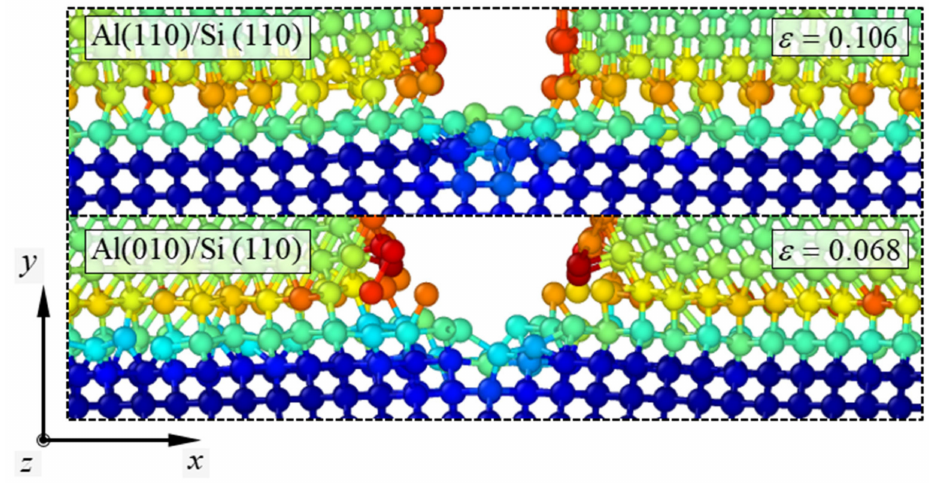
Figure 5. Atomic configurations of the interfaces in the Al(110)/Si(110) and Al(010)/Si(110) models at the failure strain. The color of the atoms indicates the atomic potential energy. The nanofilm thickness is approximately 3